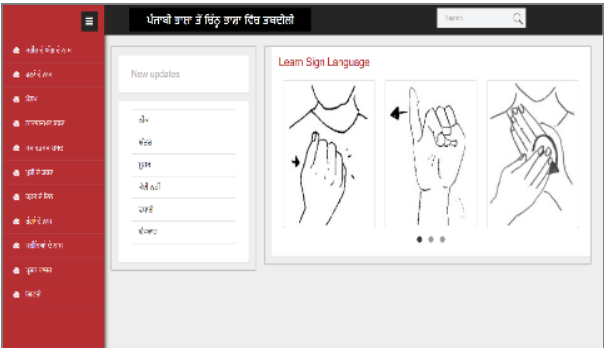
Figure. 3(c). HamNoSys and SiGML code of selected word “One ( ਇੱਕ )”